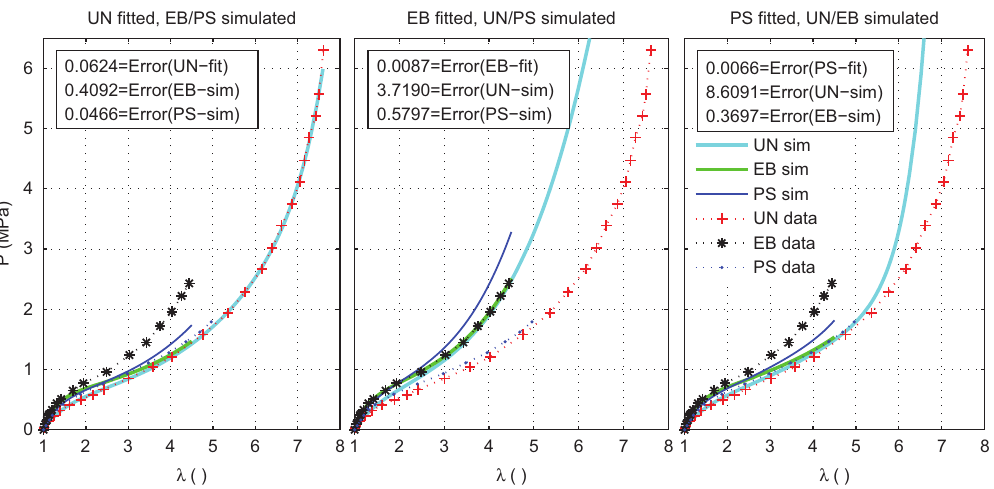
Figure 2 Performance of the Ogden model on the Treloar data for three term expansion in the series, i.e., M = 3. The fitting quality is good to excellent in the UN (left). Overestimations are observed for the UN simulations by the EB- and PS-fitted para- meters (middle and right,